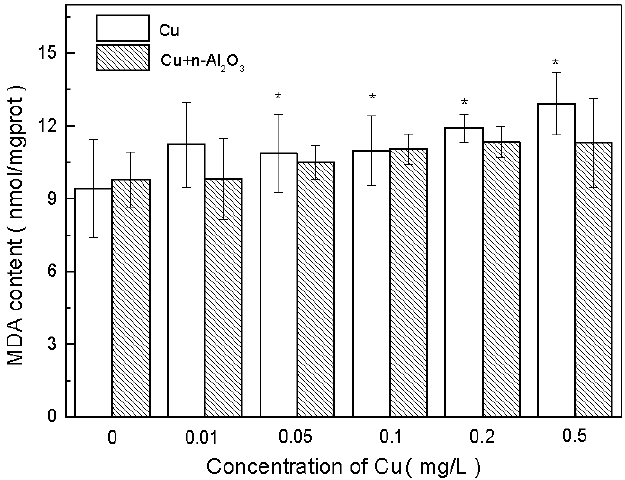
Figure 5. Malondialdehyde (MDA) concentrations in S. obliquus exposed to copper and copper/nano-Al 2 O 3 systems at different concentrations of copper after 72 h. Data are mean ± SD ( n = 3). Asterisks indicate the significance of differences ( p < 0.05) between the control and the exposed treatments. Pound signs indicate the significance of differences ( p < 0.05) between the copper system and the copper/nano-Al 2 O 3 system at the same concentration of copper.